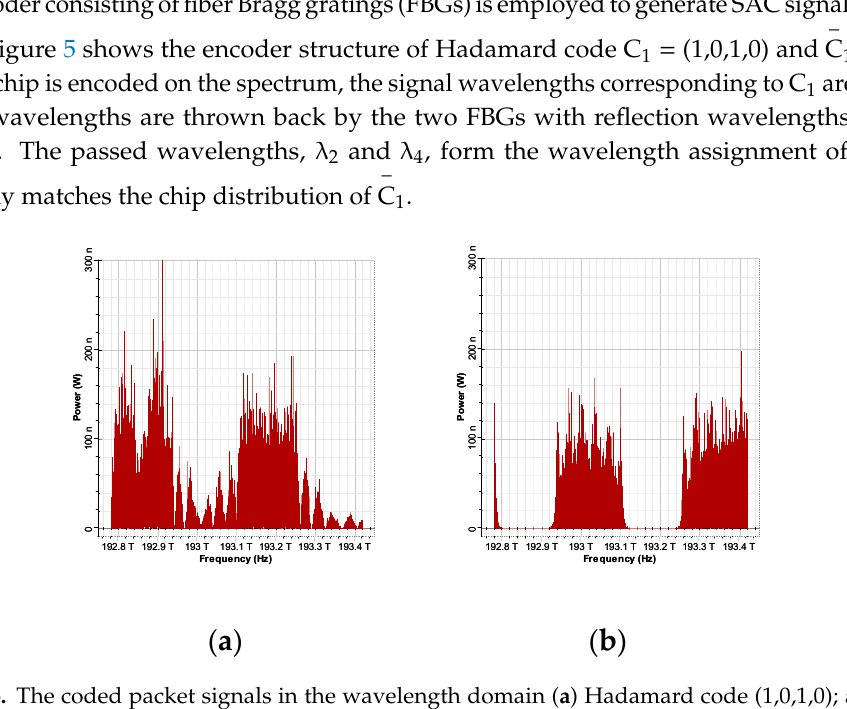
Figure 4. Encoder structure of Hadamard codes with code length N = 4. FBG: fiber Bragg grating.